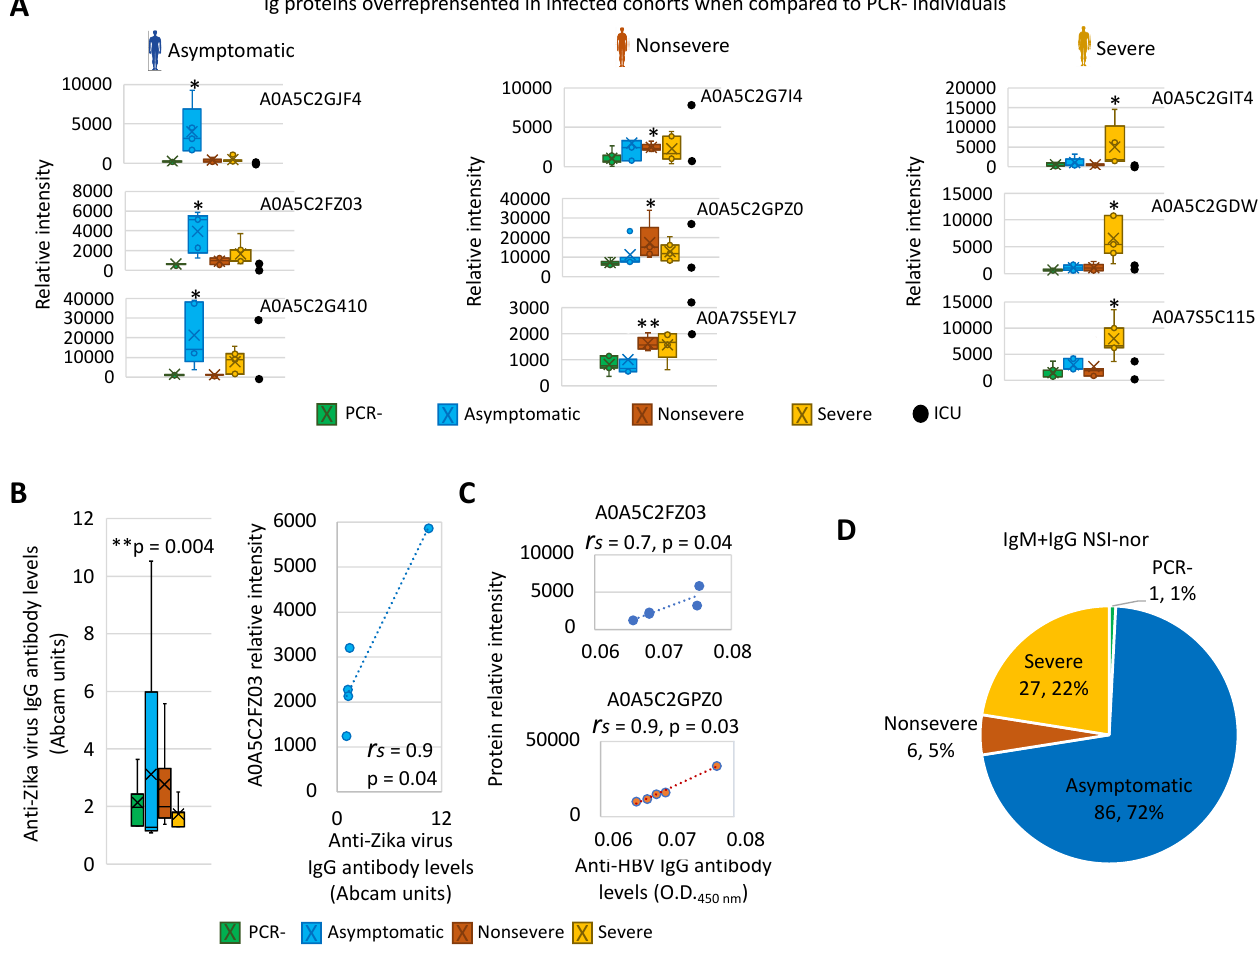
Figure 3. Validation of serum Ig proteins overrepresented in vaccinated infected individuals. ( A ) Changes in Ig-protein mass-spectra relative intensity for selected overrepresented Ig in individual samples in all PCR– and PCR+ cohorts. Relative intensity was compared between PCR– and PCR+ cohorts by Welch’s unpaired t-test (* p < 0.05, ** p < 0.005; n = 5 biological replicates). Samples from individuals in the ICU were only included as reference for selected proteins. ( B ) Independent analysis of predicted biomarker A0A5C2FZ03 for anti-Zika virus Ig levels. Antibody levels were compared between PCR– and PCR+ cohorts by Chi-squared test ( p = 0.004 for asymptomatic cohort). A Spearman’s Rho correlation analysis was conducted between virus cross-reactive Ig levels and proteomics-protein relative intensity ( p < 0.05). ( C ) Independent analysis of predicted biomarkers A0A5C2FZ03 and A0A5C2GPZ0 for anti-HBV Ig levels in asymptomatic and non-severe cohorts, respectively. A Spearman’s Rho correlation analysis was conducted between HBV cross-reactive Ig levels and proteomics-protein relative intensity ( p < 0.05). ( D ) A human-autoantibody general sur- vey identified proteins reactive to IgM and IgG autoantibodies with significant NSI-nor values in PCR – and PCR+ cohorts. Proteins were distributed based on the highest NSI-nor average IgM+IgG value.